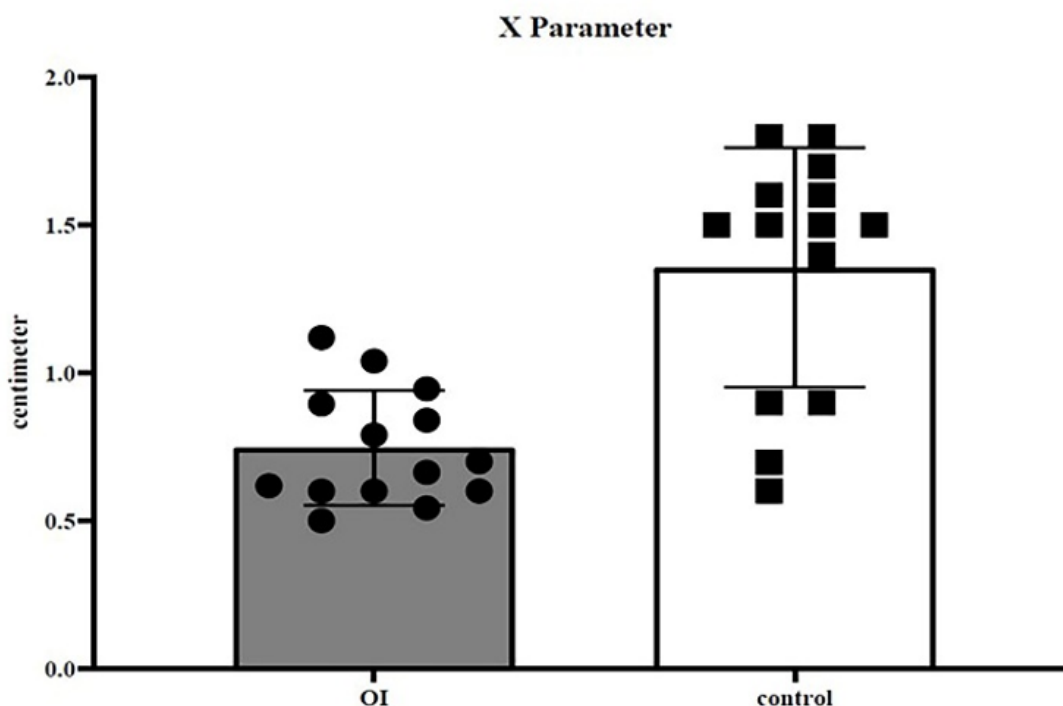
Figure 5. Third dataset (parameter X of the OI population vs. parameter X of the control group population); the t -test showed a p -value < 0.0001.